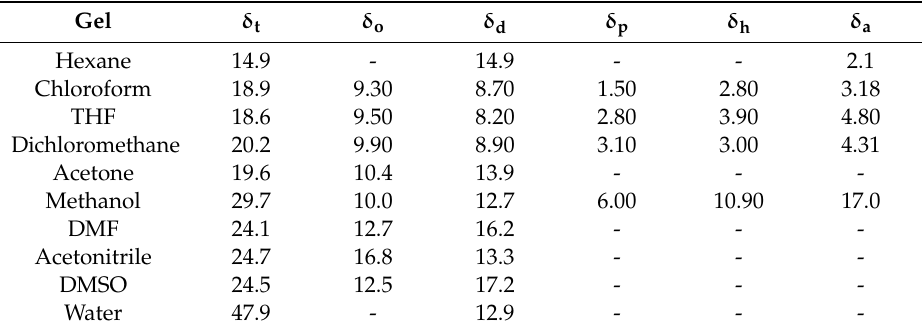
Table A2. Hildebrand solvent parameters for a selection of solvents investigated in this paper (-, not